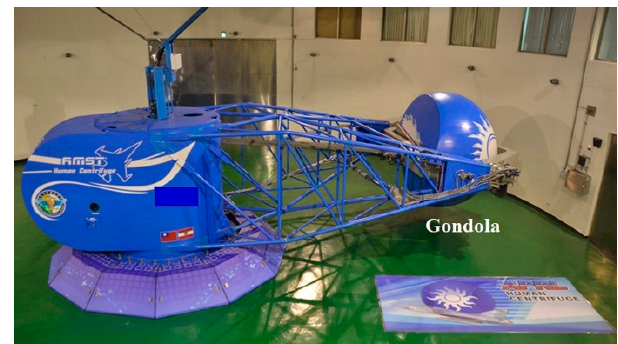
Figure 3. Human centrifuge in APRL.